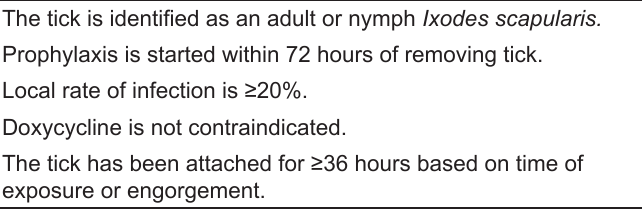
Table 2. Criteria for doxycycline prophylaxis after tick bite. The tick is identified as an adult or nymph Ixodes scapularis. Prophylaxis is started within 72 hours of removing